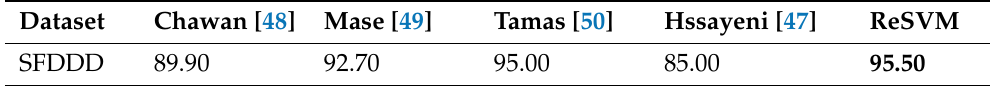
Table 7. Comparison using SFDDD